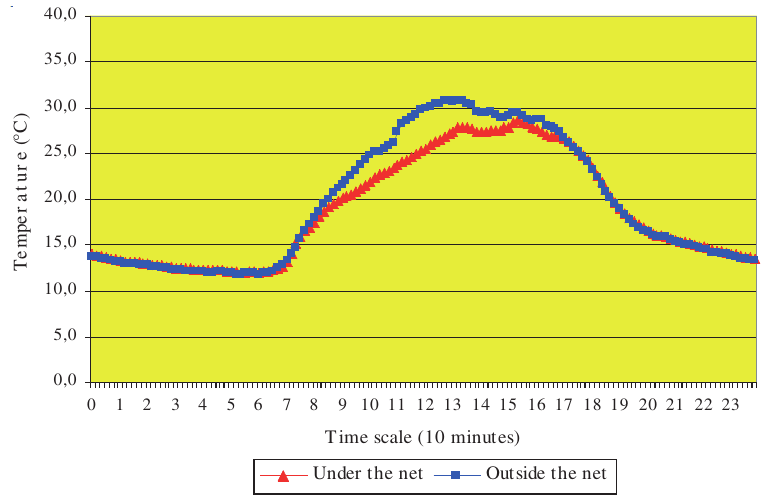
Figure 1. The mean daily course of temperature under the hail protection net and outside of it /Pallag 2011 June 1 – September 30/